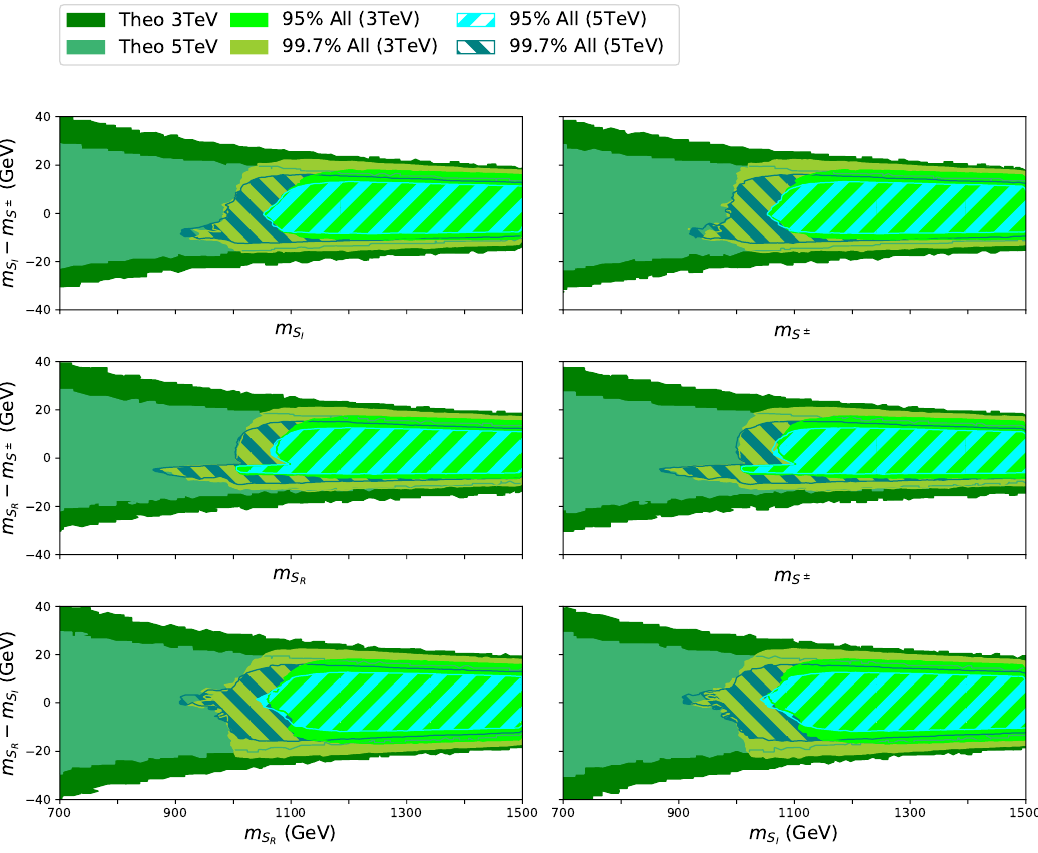
Figure 6 . Comparison of theoretical and global constraints on the mass splittings, as a function of the different scalar masses, imposing RG stability and perturbative unitarity up to 3 and 5 TeV. For the global fit we plot the 95% and 99.7%